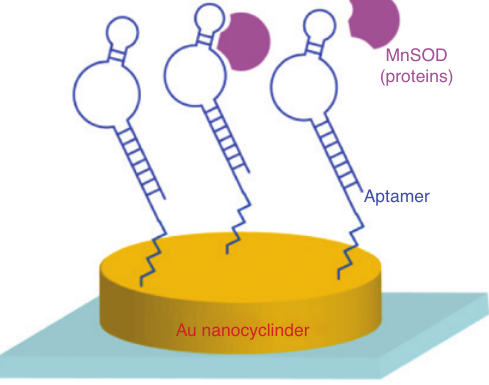
Figure 1: Schematic of the SERS sensor of MnSOD using a specific